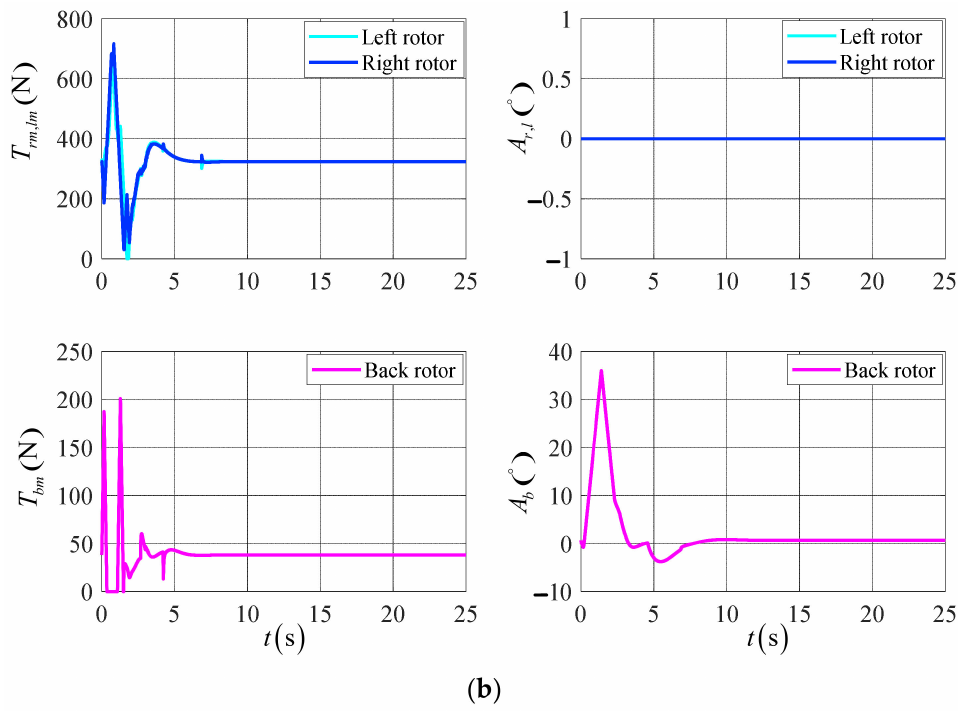
Figure 13. The variation of the UAV actuators’ control in the fixed height flight. ( a ) The results of the DTVC scheme; ( b ) the results of the conventional control